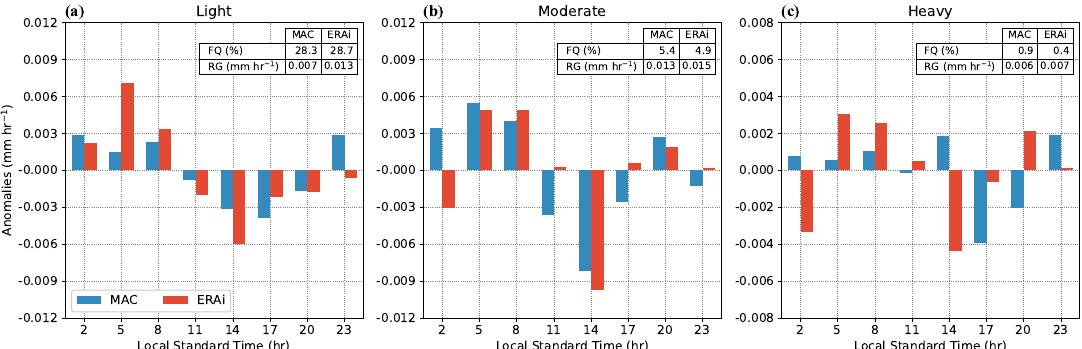
Figure 2. Diurnal anomalies of precipitation for both MAC observations and the ERA-Interim dataset, separated by categories: ( a ) light (0.2 ≤ P < 0.5 mm h − 1 ), ( b ) moderate (0.5 ≤ P < 1.5 mm h − 1 ), and ( c ) heavy precipitation (P ≥ 1.5 mm h − 1 ). Tables show the frequencies of occurrence (FQ) and the diurnal range